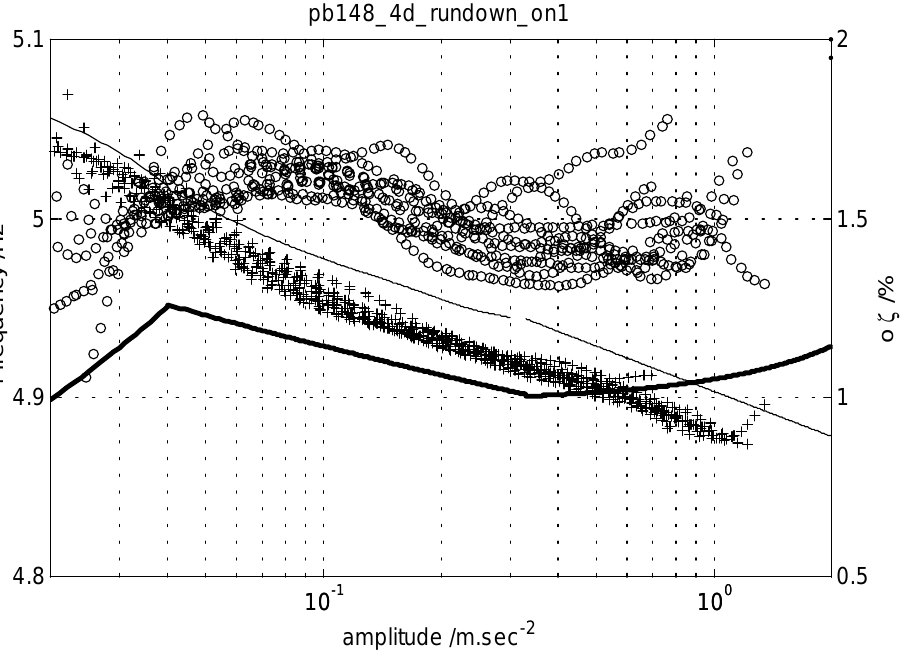
Fig. 6. Frequency ( + ) and damping (o) estimates from free decay of mode V1 with single human occupant. Values for empty bridge (from Fig. 5) are shown as solid